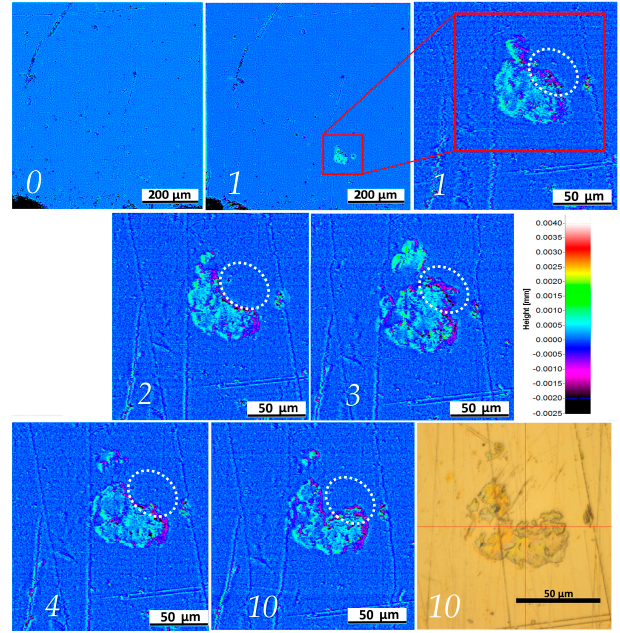
Figure 6. A sequence of measurements of the lower contact during a cold switching sequence at 100 µN normal contact force. At 0 (before switching), 1, 2, 3, 4 and 10 cycles. The white dotted region shows an unstable region of deposition.